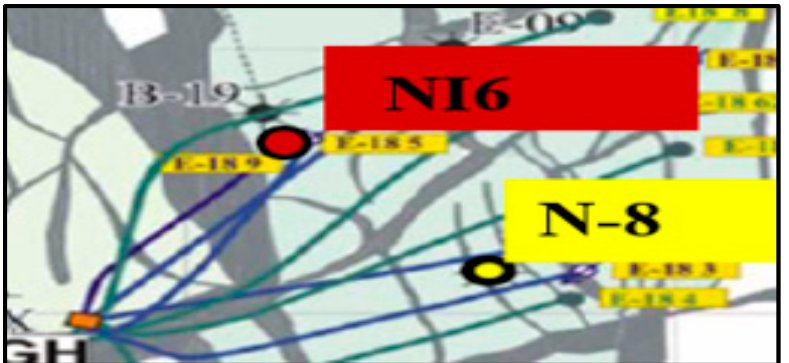
Figure 21. Well N-8's location relative to Injector NI6. Figure 21. Well N-8’s location relative to Injector